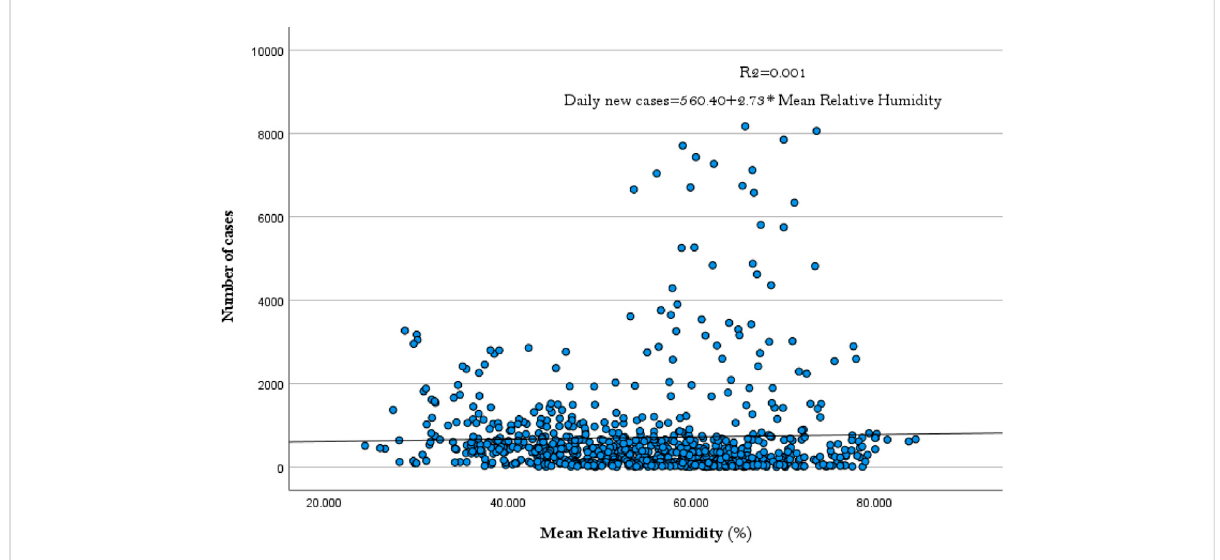
FIGURE 9 Scatter diagram and simple regression line presenting the relationship between new daily cases of SARS-CoV-2 and mean average relative humidity in Bahrain for 27 months of recorded cases.